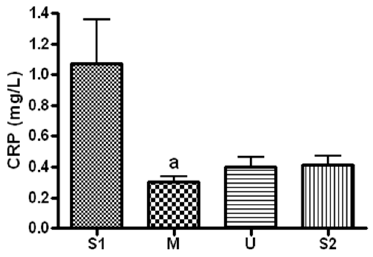
Figure 10. Serum CRP concentration in different locations. Values are mean ± S.D. Significance ( p < 0.05) is denoted by a: relative to S1. S1: Before start in Seoul, M: Moscow U: Ulaanbaatar S2: Return to Seoul.